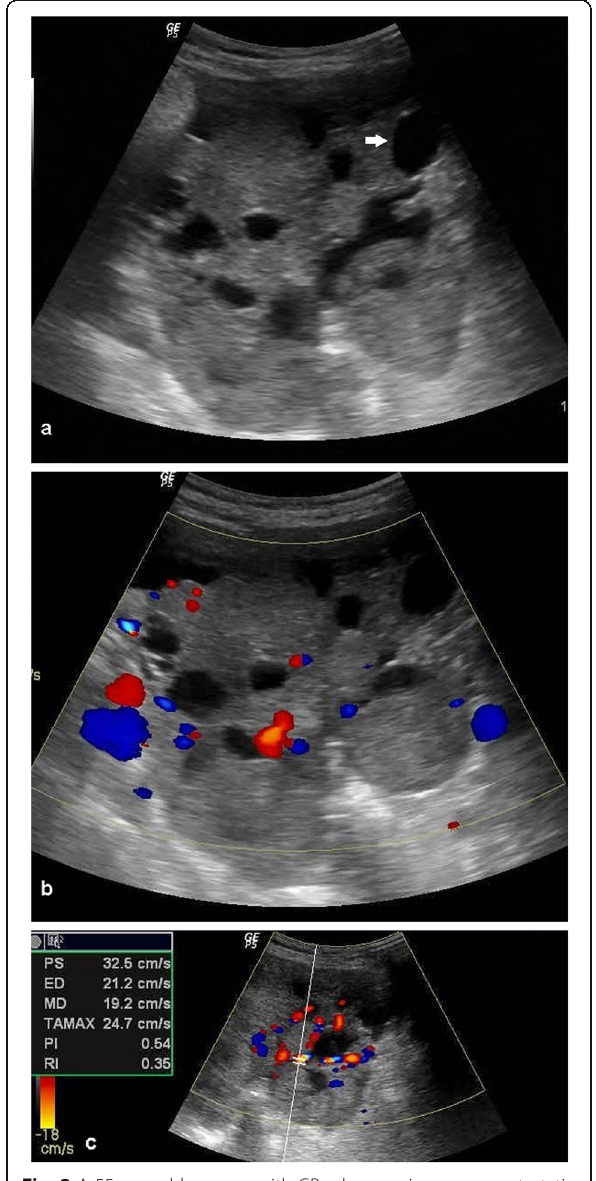
Fig. 2 A 55-year-old woman with GB adenocarcinoma on metastatic work up. a Transabdominal ultrasound shows non-hyperechoic soft tissue mass with cystic component within (white arrow). b Doppler ultrasound detects multiple central blood flow within the solid mass. c Spectral Doppler shows 0.3 RI and 0.5 PI. The histopathological examination after true-cut needle biopsy revealed metastatic